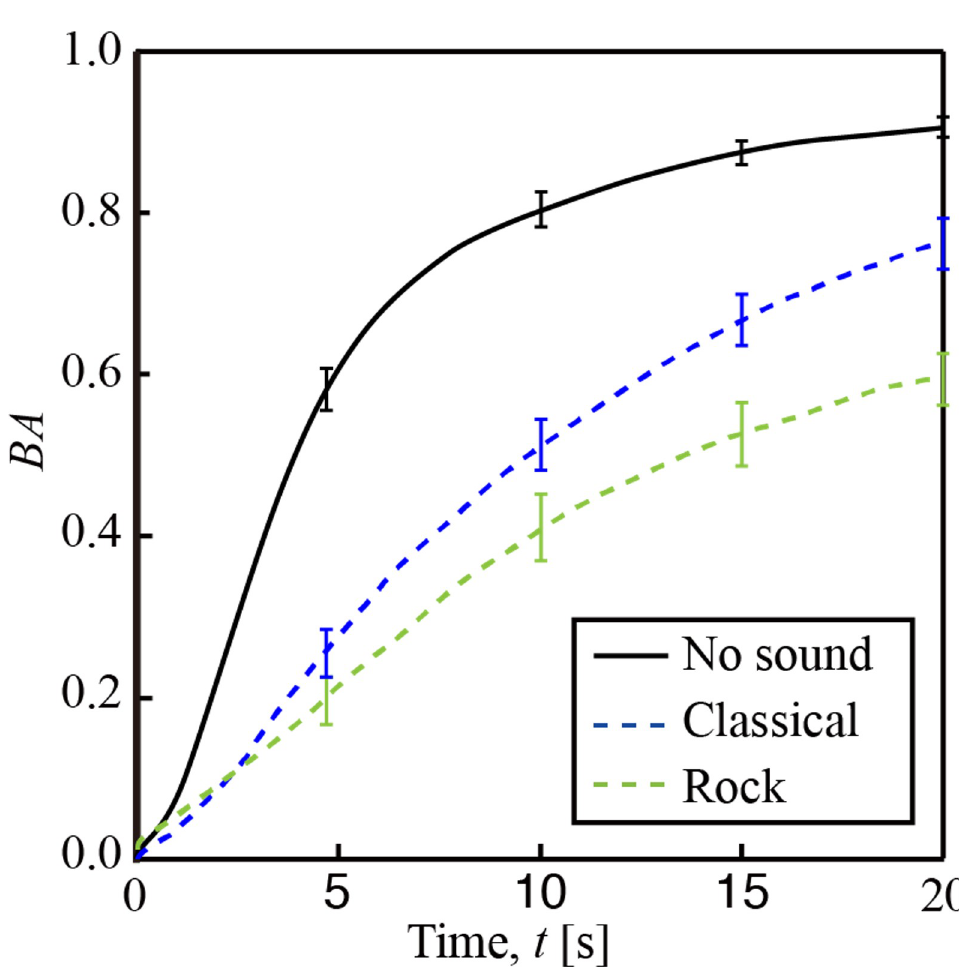
Fig 6. Temporal variation of BA from leaf of an arugula plant under exposure to sounds of classical and rock music. Black solid line, blue dotted line, and green dotted line respectively indicate control, classical music, and rock music. Error bars correspond to standard error of the